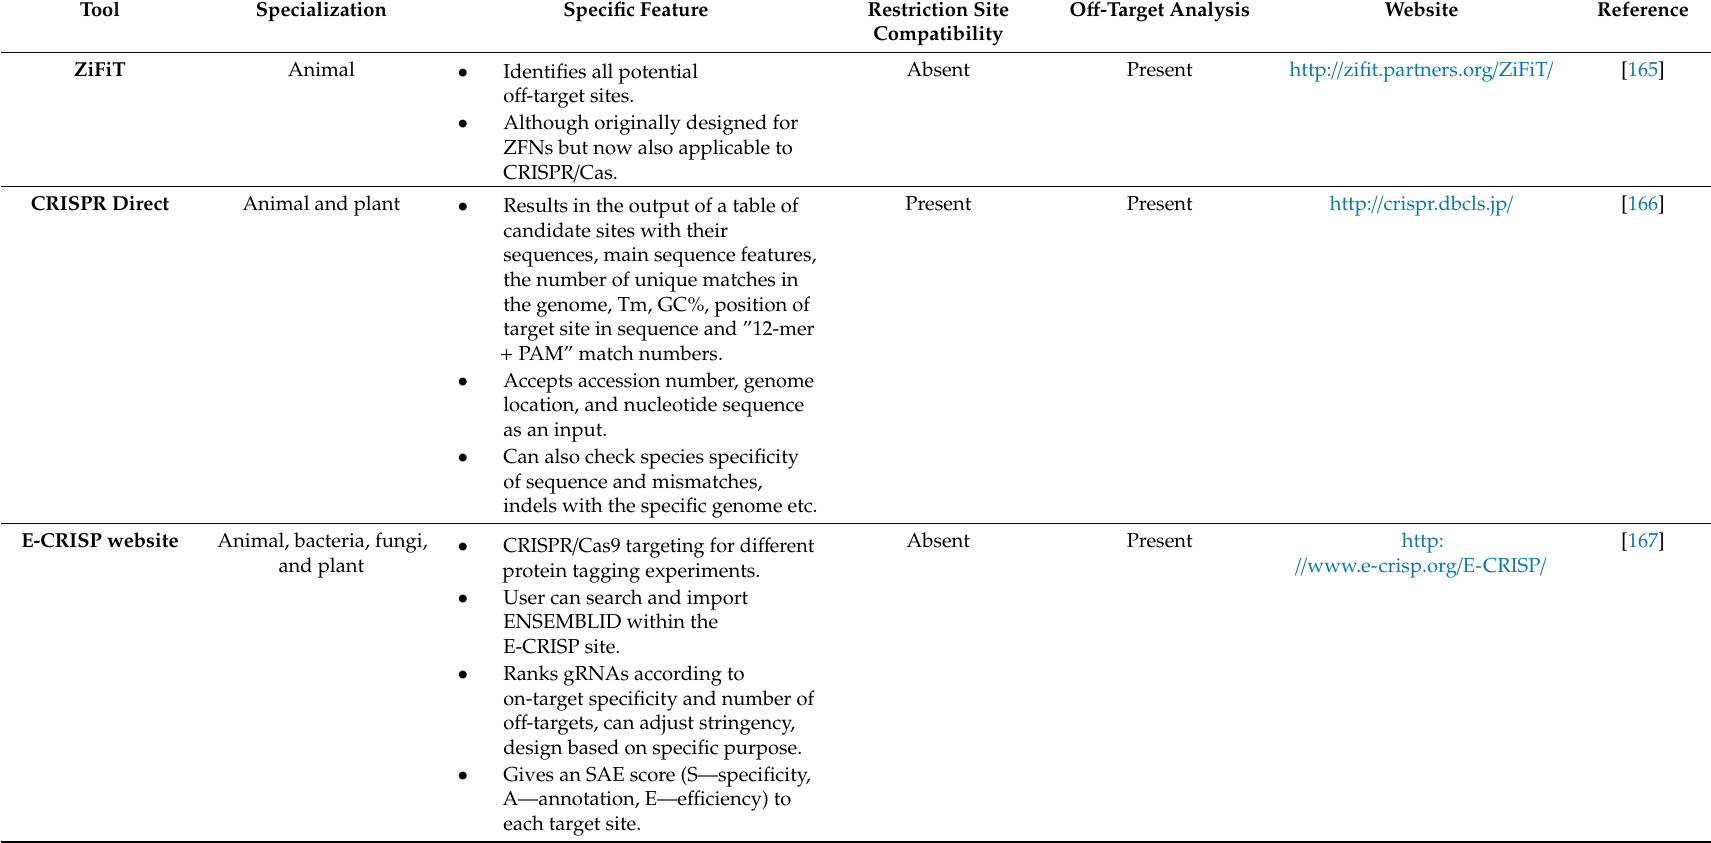
Table 2. CRISPR associated